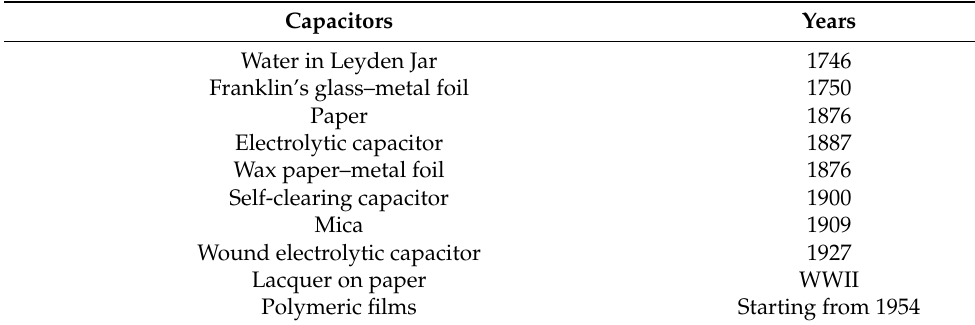
Table 2. History of capacitor development